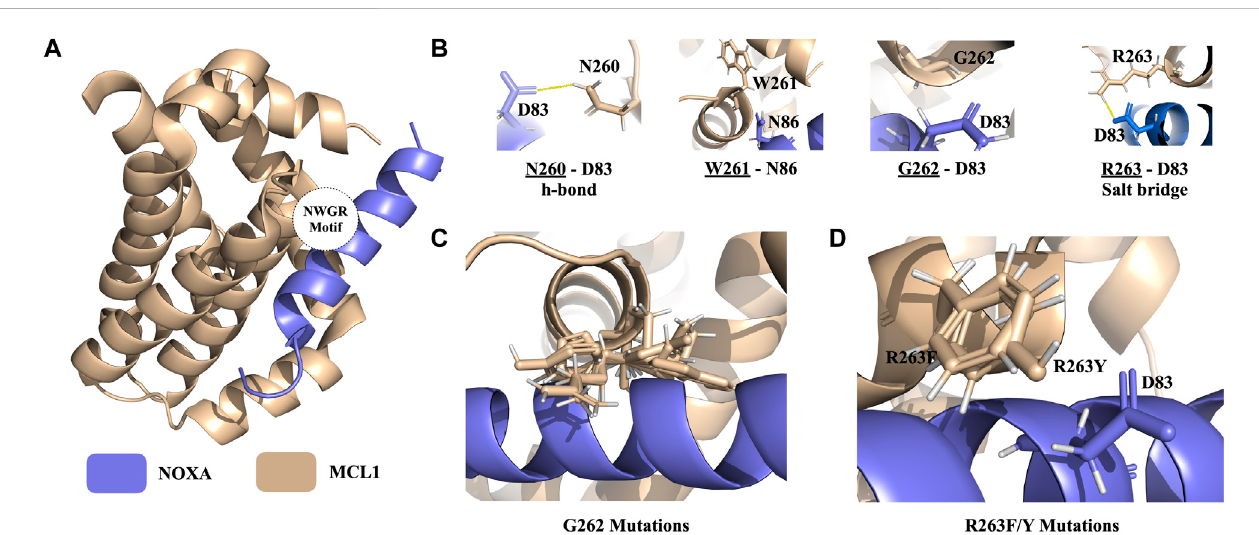
FIGURE 5 PROT-ON results on MCL1 from the MCL1-NOXA complex with 2.5 IQR threshold and PSSM input. (A) The structure of the MCL1-NOXA complex (PDB ID:2NLA).ThewheatandslatecolorsdenotetheMCL1andNOXA,respectively.ThepositioningoftheNWGRmotifisencircled. (B) NWGRmotifofMCL1with closebyaminoacidsshownwithsticksonNOXA.Thepolarinteractionsareshowninsolidyellowlines. (C) Orientationsofthedepletingmutationsgenerated for G262. (D) Orientations of the depleting mutations generated for